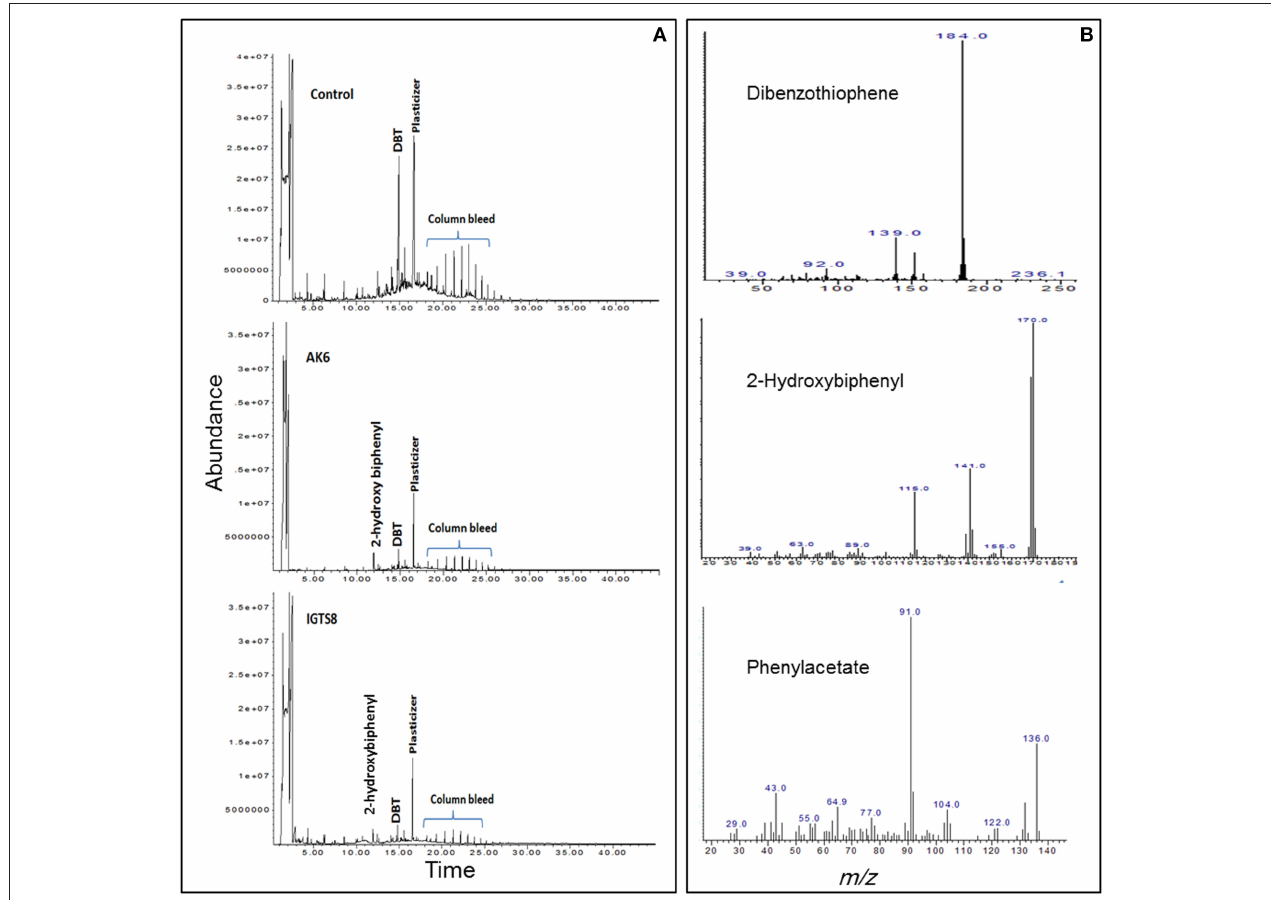
FIGURE 4 | (A) Gas chromatogram showing the biotransformation of DBT in resting cell assays for the AK6 mixed culture and the reference strain R. erythropolis IGTS8. (B) Mass spectra for compounds detected in ethylacetate extracts of the resting cell assays.